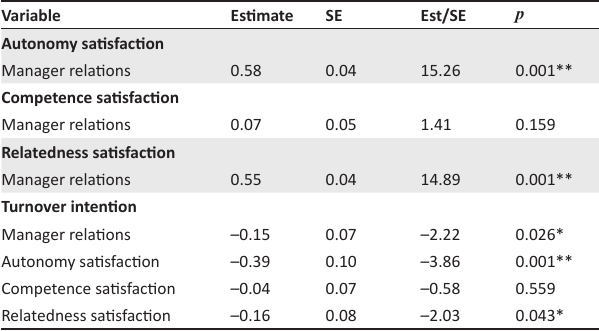
TABLE 4: Standardised regression coefficients of the variables.